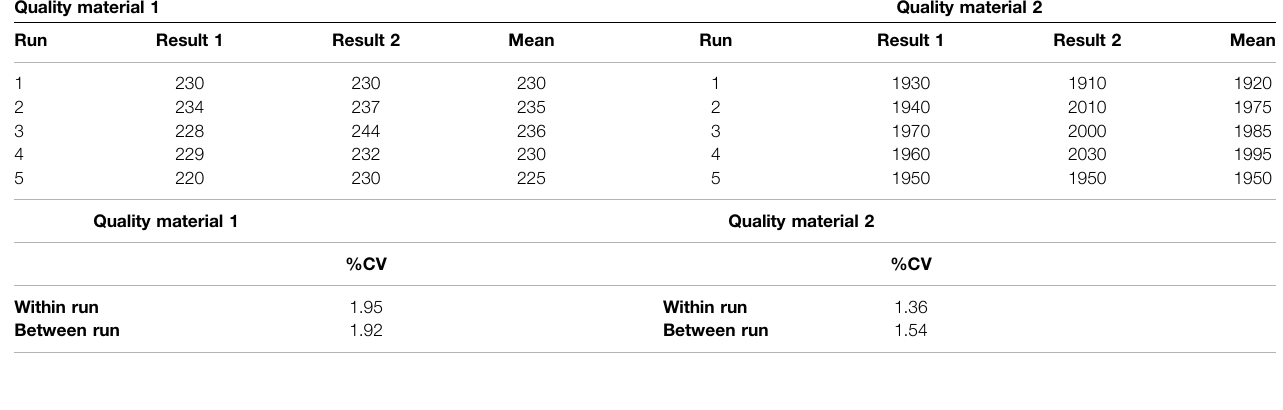
TABLE 2 | Precision of quantitation of 8-isoprostane in BAL fl uid (pg/ml). Quality material 1